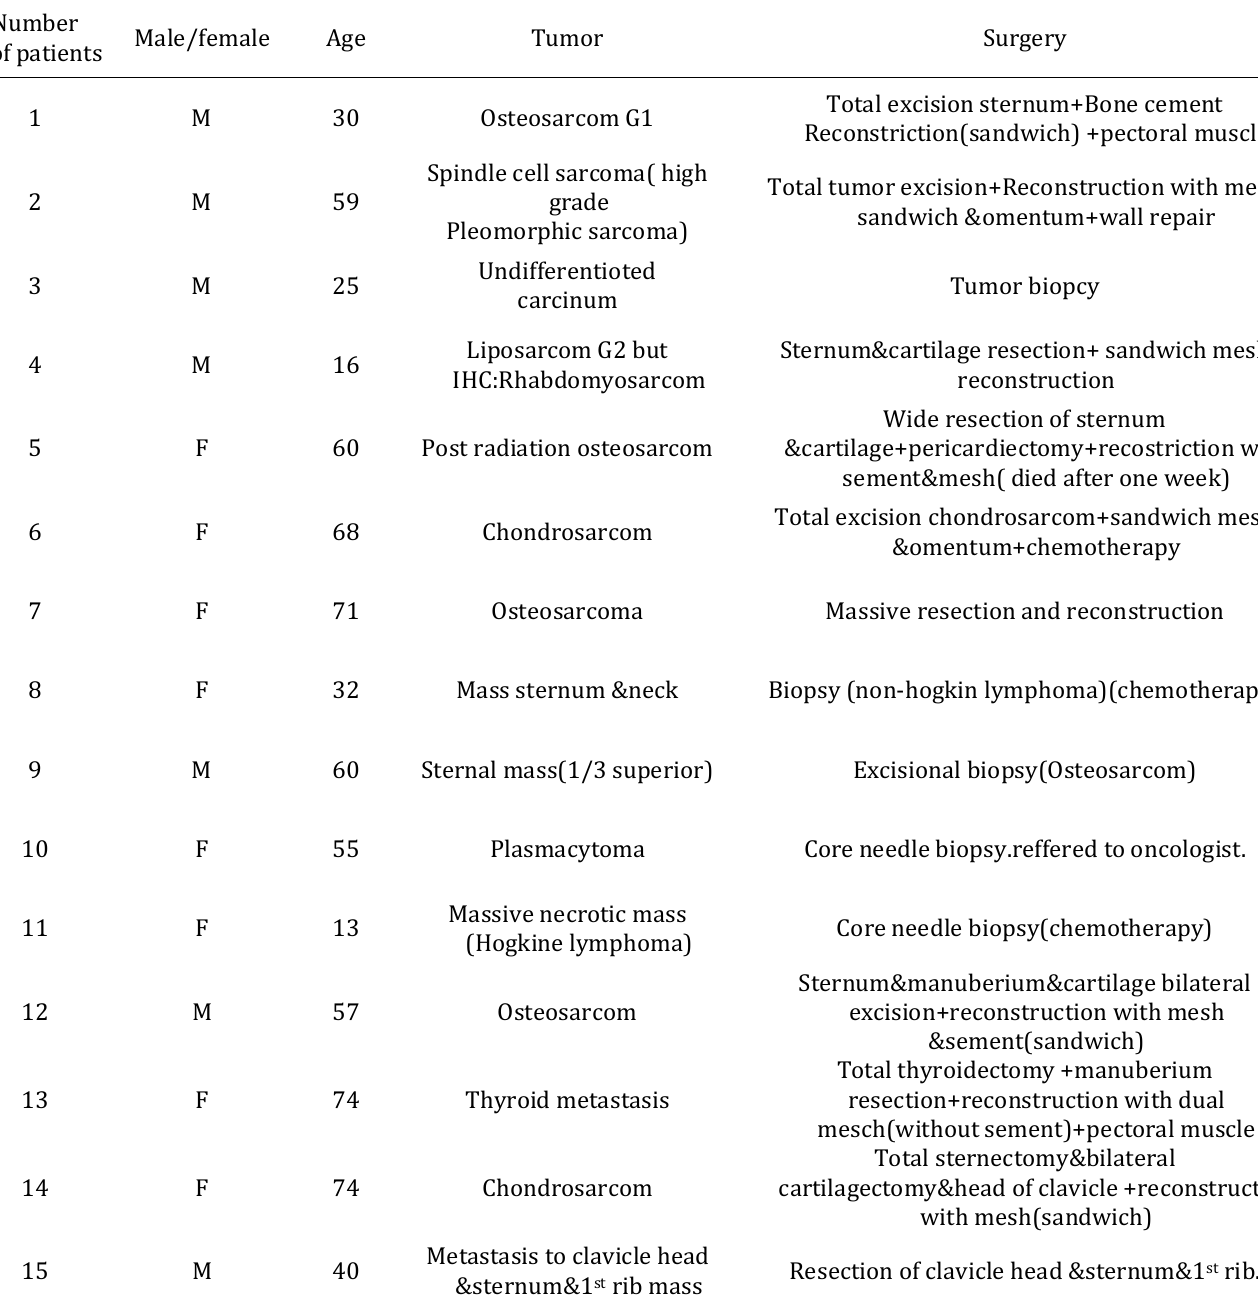
Table 1: Patient characteristics and kinds of tumor Number of patients